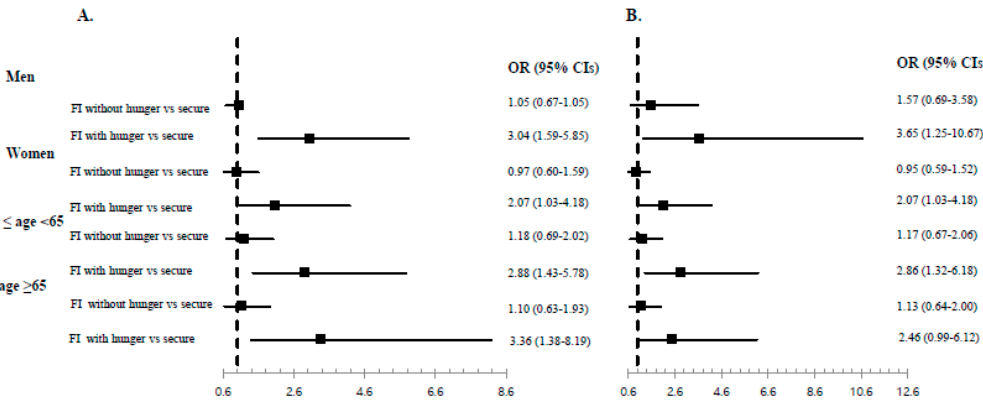
Figure 2. Adjusted ORs and 95% CIs in subgroup analysis by sex and age groups. ( A ) ORs were calculated using multiple logistic analysis after adjusting for age, sex (in age groups), and BMI. ( B ) ORs were calculated using multiple logistic analysis after adjusting for age, sex (in age groups), BMI, education level, household income, smoking, residential area, and occupation type. OR, odds ratio; 95% CI, 95% confidence interval; FI, food insecurity.